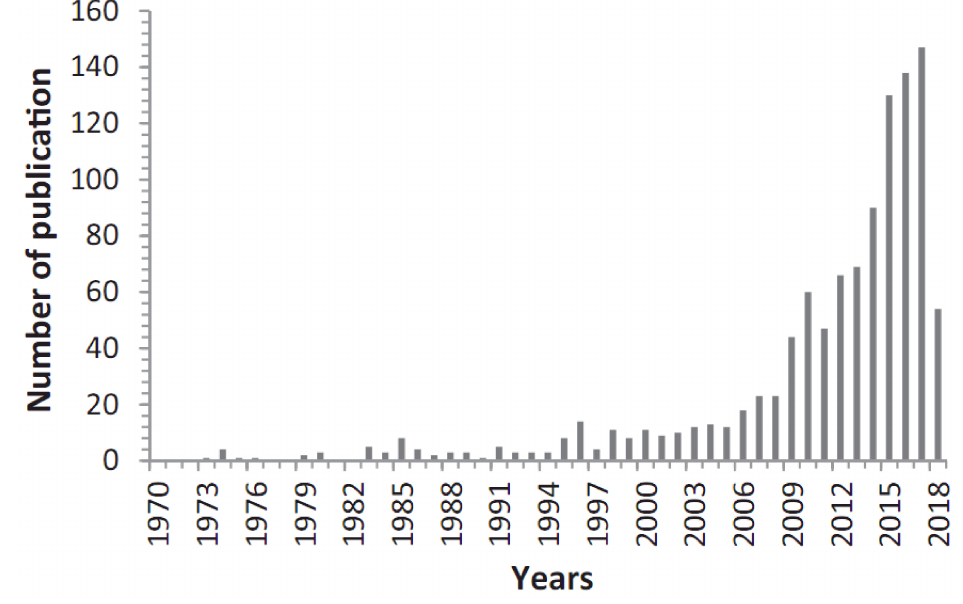
Figure 5. Previous studies concerning both concrete/mortar and cement pastes’ influence on self- healing, up to 2018 (Adapted with permission from Elsevier